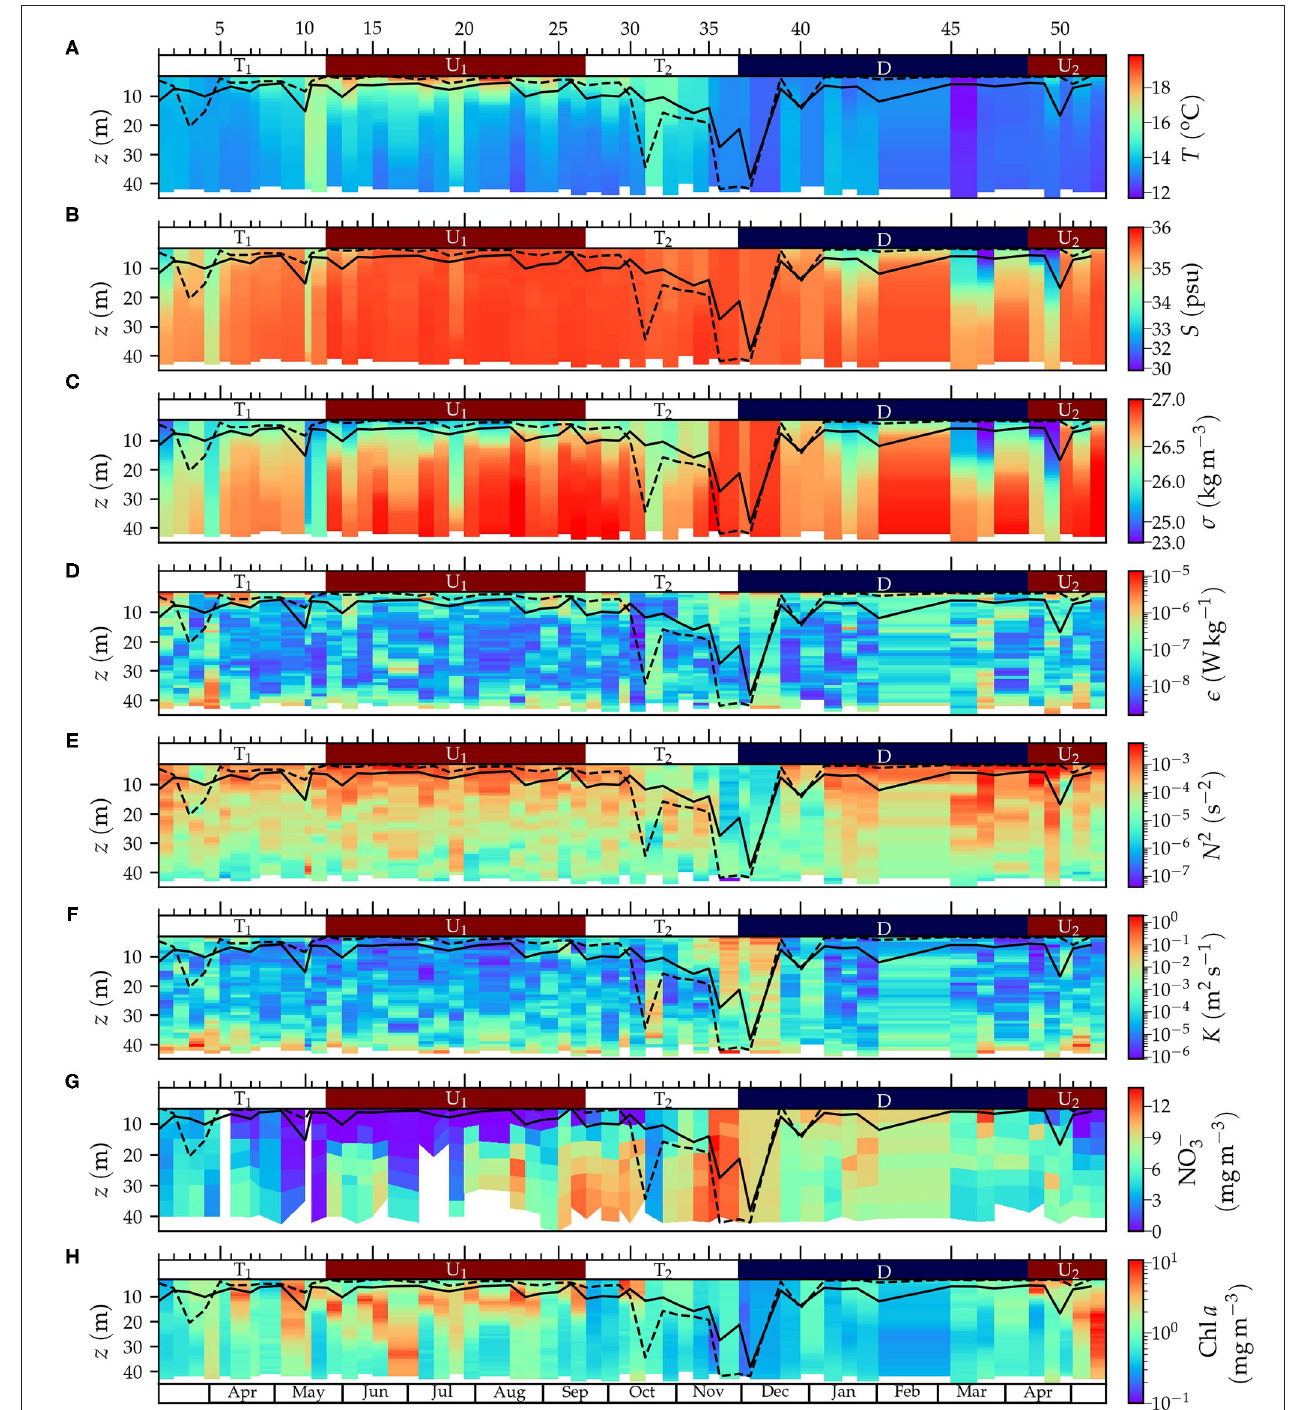
FIGURE 3 | Time-series of the vertical distribution of (A) temperature ( T ), (B) salinity ( S ), (C) density anomaly ( σ ), (D) turbulent kinetic energy dissipation rate ( ǫ ), (E) squared buoyancy frequency ( N 2 ), (F) turbulent diffusivity ( K ), (G) nitrate concentration (NO − 3 ), and (H) Chl a concentration. (A–F,H) Derived from data obtained from the microstructure profiler and (G) from water samples collected from the Niskin bottles. The solid and dashed black line denote the turbulent layer and mixed-layed depth, respectively. The ticks and numbers on the top axis indicate the sampling number and the colors, the periods for upwelling (U 1 and U 2 , in red), downwelling (D, in blue), and transition (T 1 and T 2 , in